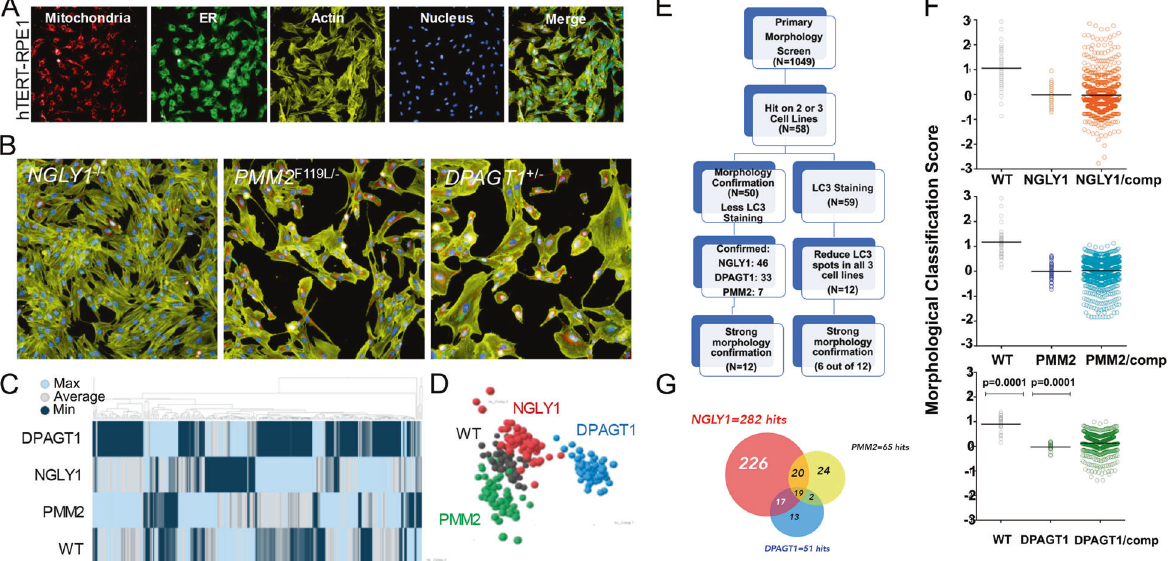
Fig. 5 High-throughput drug screen against cellular morphology via cell painting identi fi es compounds able to revert aberrant line- speci fi c morphological characteristics. A Cell painting images of parental RPE-1 cells. Cells were plated in 384-well tissue culture plate and stained with MitoTracker Red (mitochondrial stain), ConcanavalinA-488 (ER stain), phalloidin-547 (actin stain), and DAPI (nuclei) as described in the “ Materials and methods ” section. B Representative cell painting images of CDDG and CDG lines. C , D Hierarchical clustering and principal component analyses of extracted morphological features distinguishes CDG and CDDG cell lines from parental RPE-1 cells. E Screening work fl ow for selection of candidate compounds. F Representative scatter plots of primary screen results for each genotype. Each dot represents one well. For RPE-1 and vehicle treated isogenic CDG and CDDG cell lines, N = 56 replicate wells. For compound treatments, each compound was tested in N = 1 well. G Venn diagram comparing the number and overlap of compounds affecting each CDG/CDDG